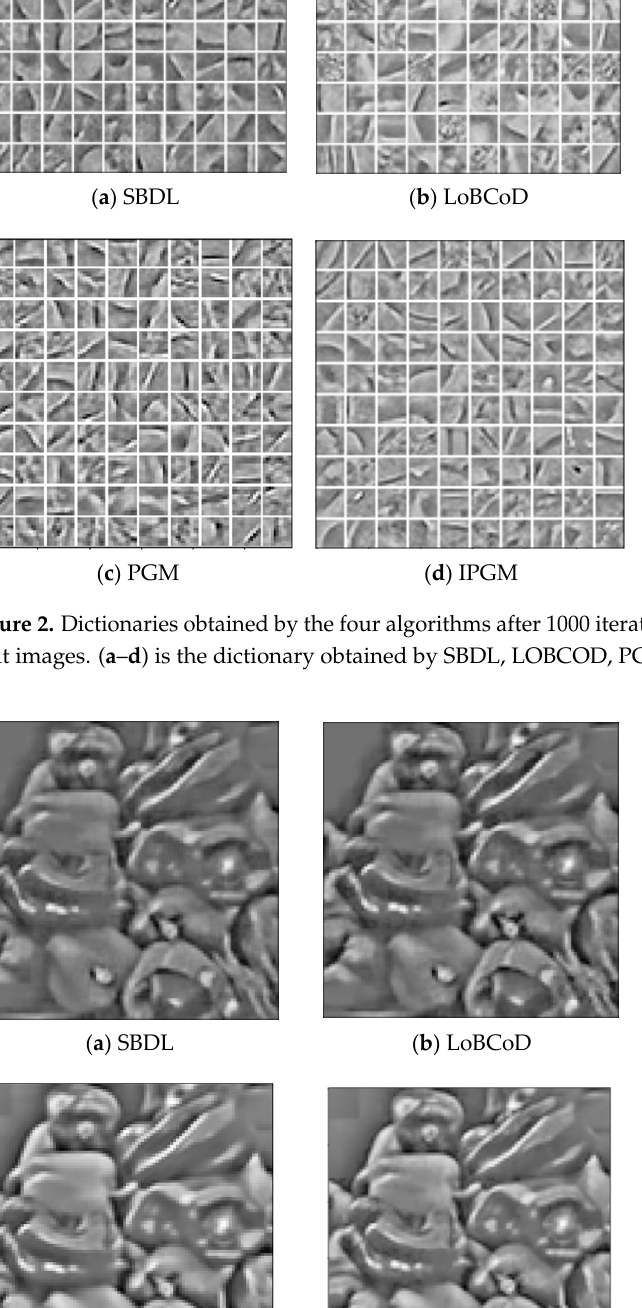
grayscale natural fruit images.